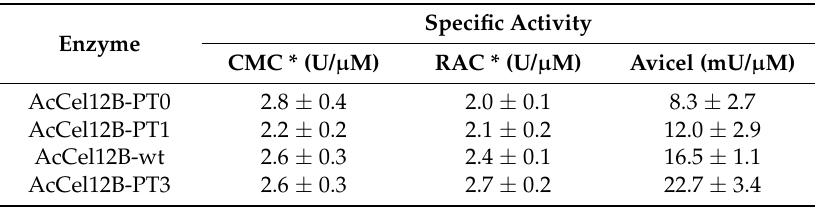
Table 1. Enzyme activity against a range of cellulosic